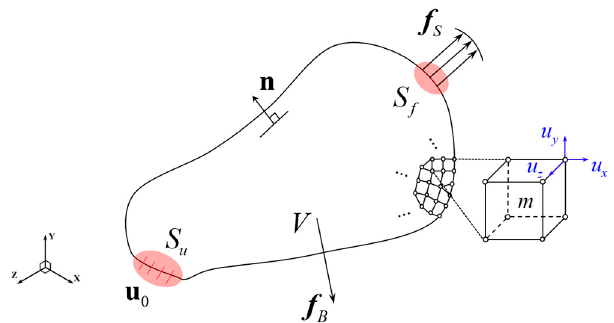
Figure 1. Discretized three-dimensional body with finite elements.